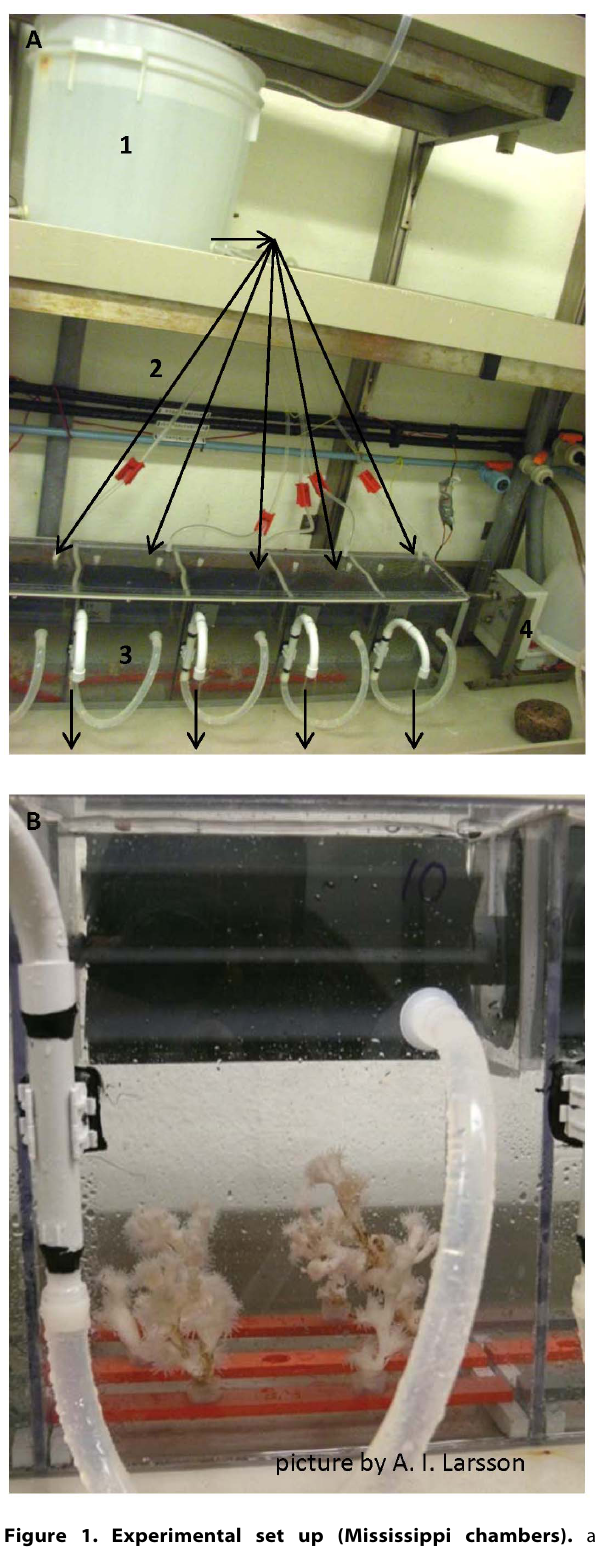
Figure 1. Experimental set up (Mississippi chambers). a) Experimental set up including the water reservoir for filtered sea water (1), the direction of the water flow indicated with arrows (2), 5 incubation chambers (3) and the motor driving the chamber paddles (4). b) Close-up of one incubation chamber (10 L) provided by A. I.